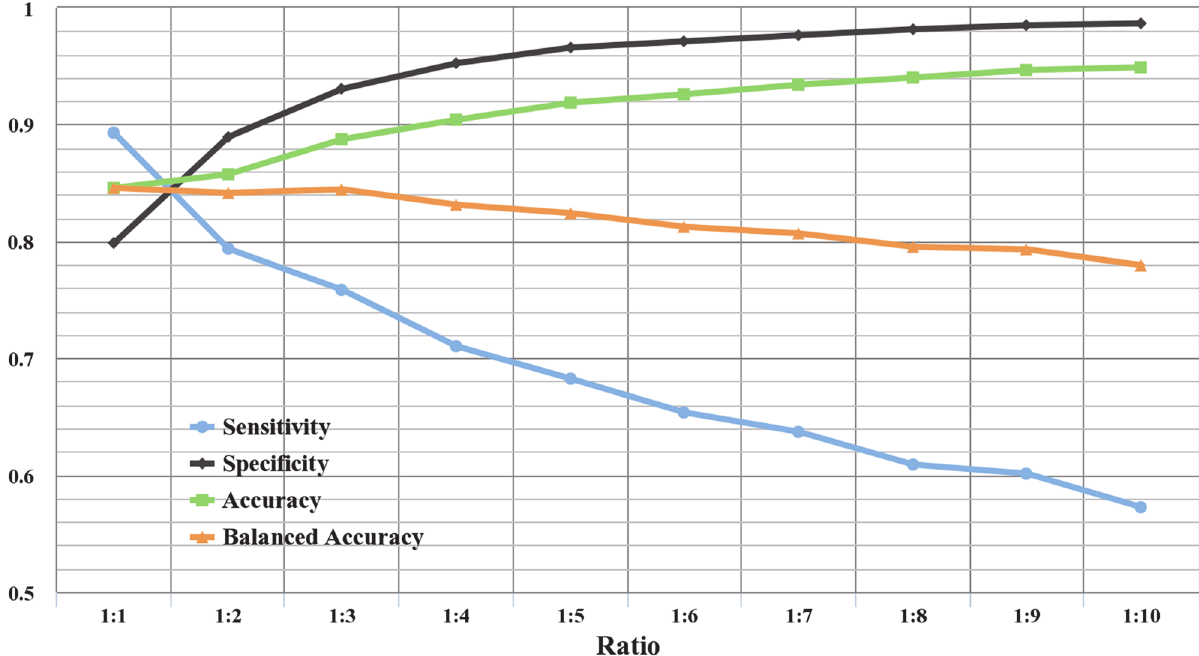
Fig 5. The averaged performance with different ratios between positive and negative samples in the training set. The ratios of the number of positive samples to negative ones are from 1:1 to 1:10,